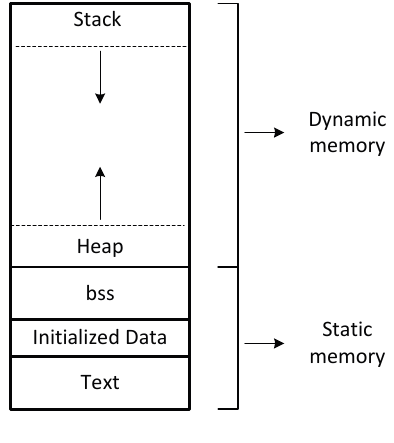
Figure 12. Layout of RAM